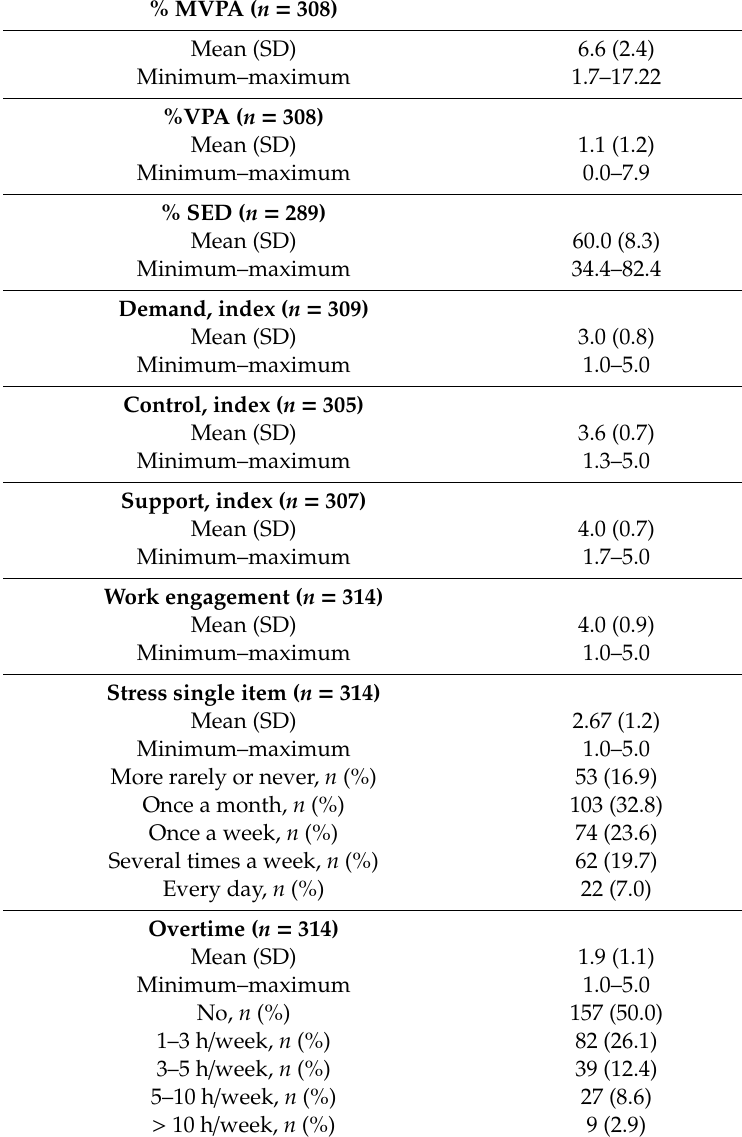
Table 1. The distribution of the sample, total n =